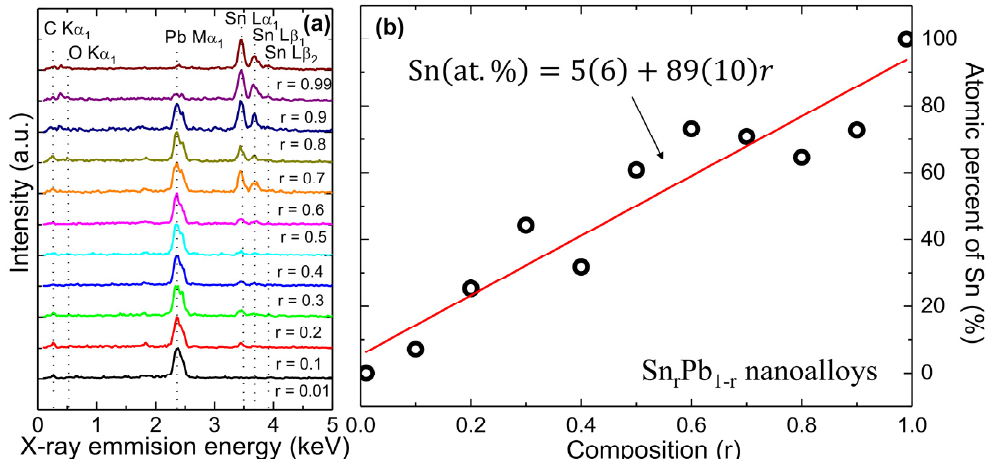
Figure 1. ( a ) Typical EDS elemental spectra reveal a series of peaks associated with Sn and Pb elements, verifying that the Sn r Pb 1-r bimetallic nanoalloys contain only Sn and Pb elements; ( b ) atomic % of Sn with respect to the initial composition of Sn r Pb 1-r bimetallic nanoalloys.